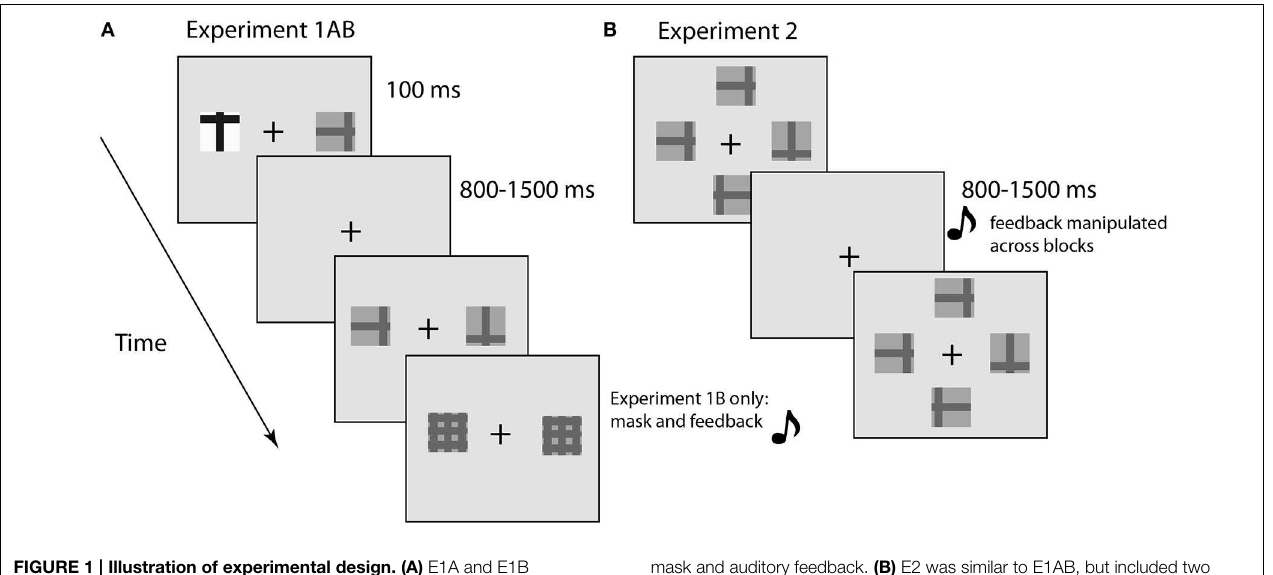
mask and auditory feedback. (B) E2 was similar to E1AB, but included two additional distractors to increase task difficulty. The duration of the display was determined for each subject using the method of constant stimuli. Feedback was manipulated across